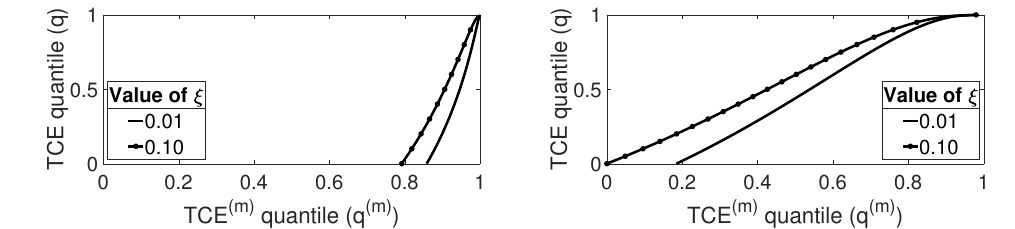
Figure 12. TCE quantile as a function of extended TCE quantile at order m = 2 with µ = 0. ( Left panel ): σ = 0.1. ( Right panel ): σ = 0.4.